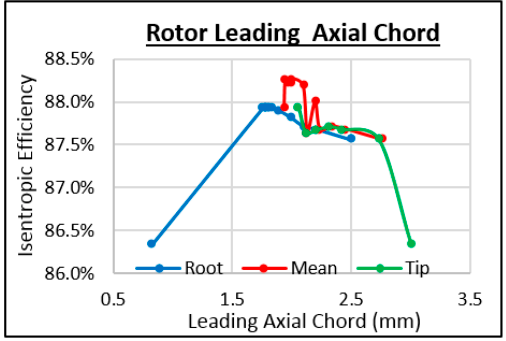
Figure 35. Study of the rotor leading axial chord.